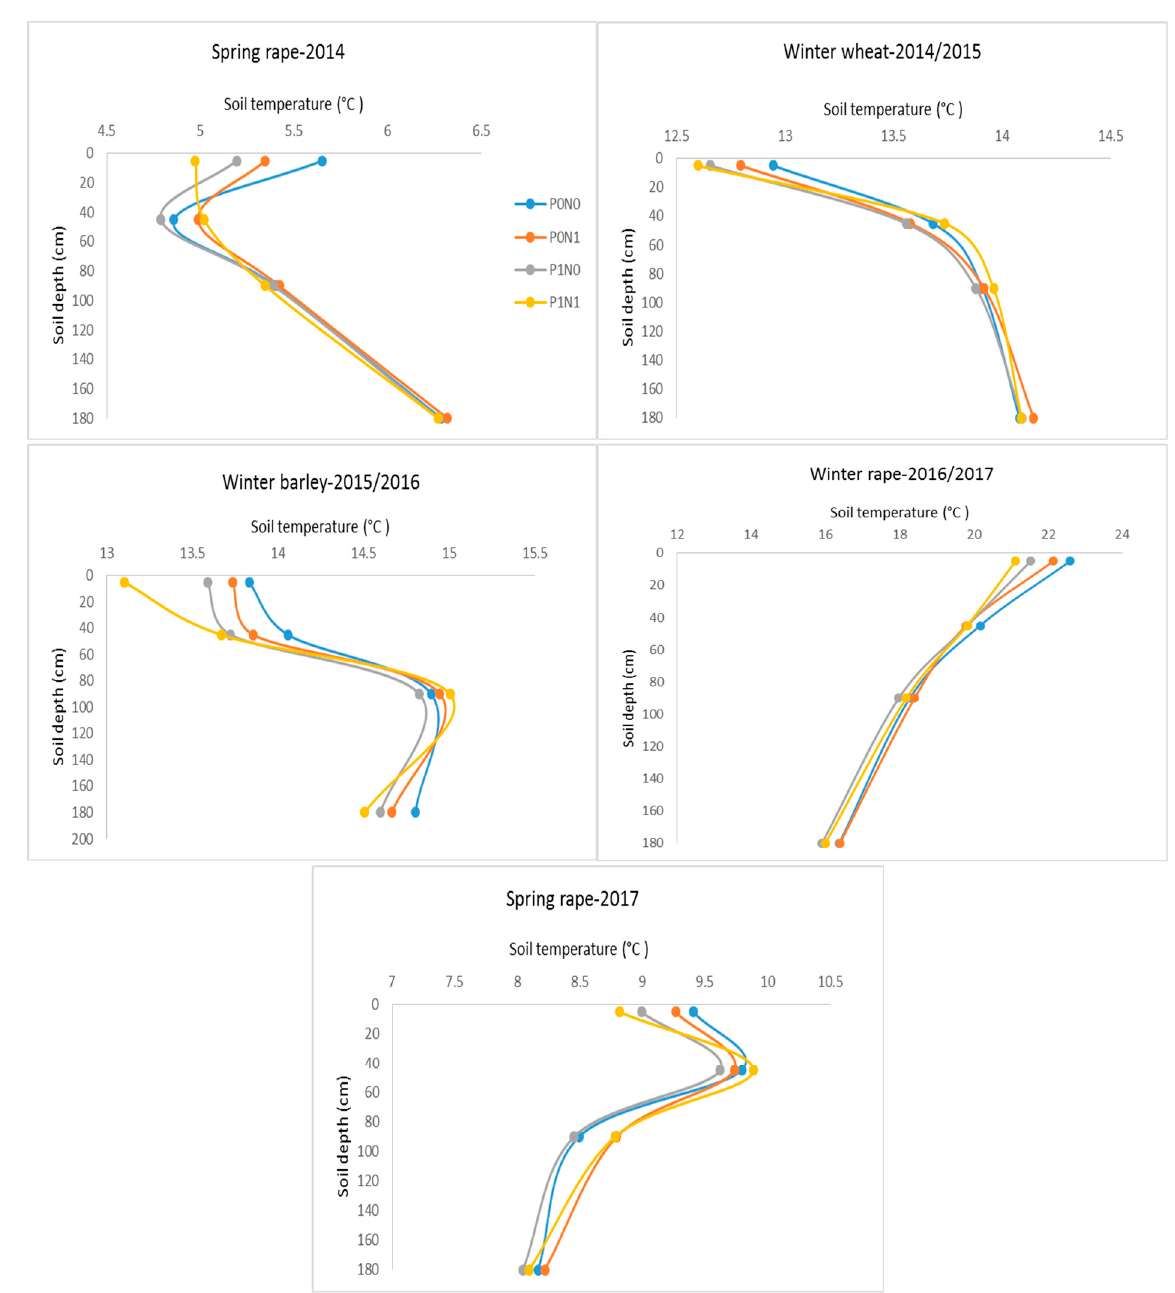
Figure 4. Soil temperature (°C) at different soil depths according to the fertilizer rate and tillage system on sowing day.